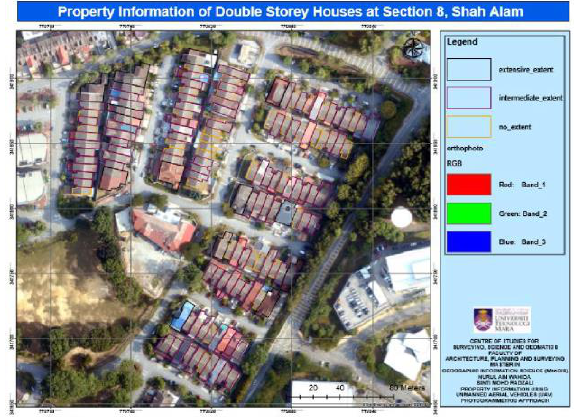
Figure 1 . Map of two-storey houses in Section 8 of Shah Alam, Selangor (Tahar & Radzali, 2018).